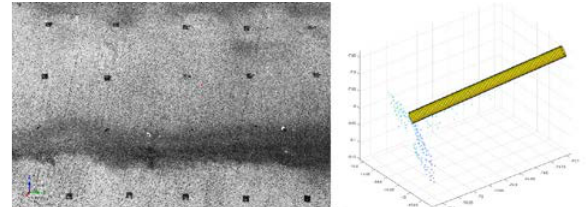
Figure 5. Example point cloud showing a number of rock bolts on site (left). On the right, a detailed geometric approximation of a cylindrical bolt and corresponding point cloud.